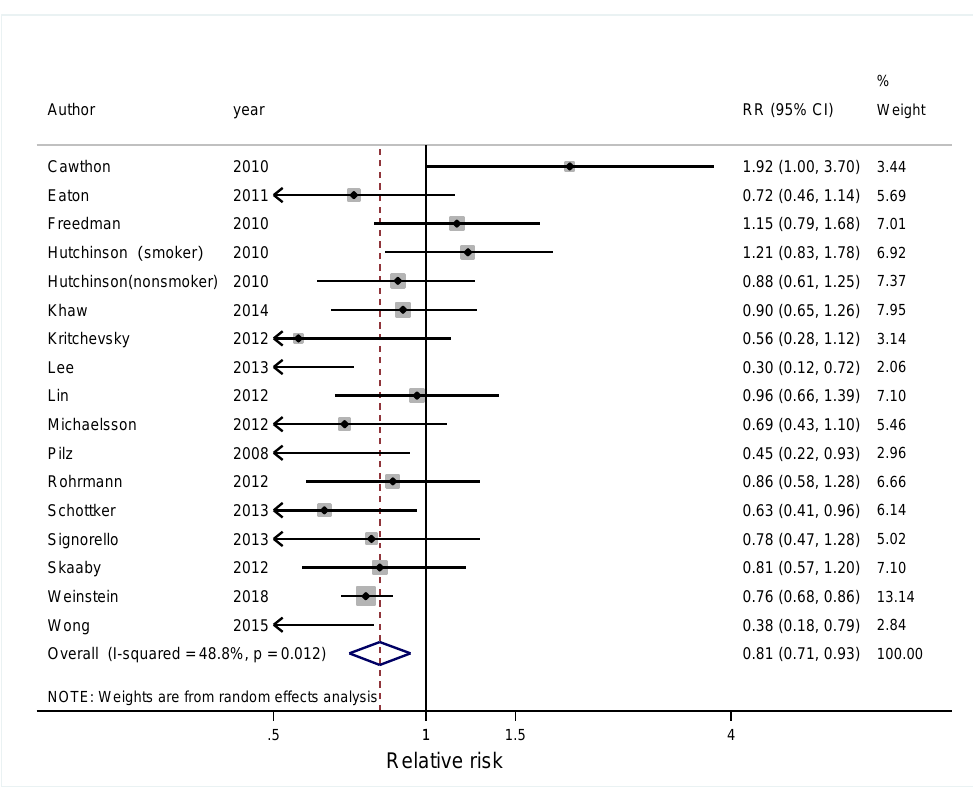
Figure 3. Forest plot to quantify the association between 25-hydroxyvitamin D and total cancer mortality. The diamonds denote the summary risk estimate, and the horizontal lines represent 95% CI. Abbreviations: RR, relative risk.